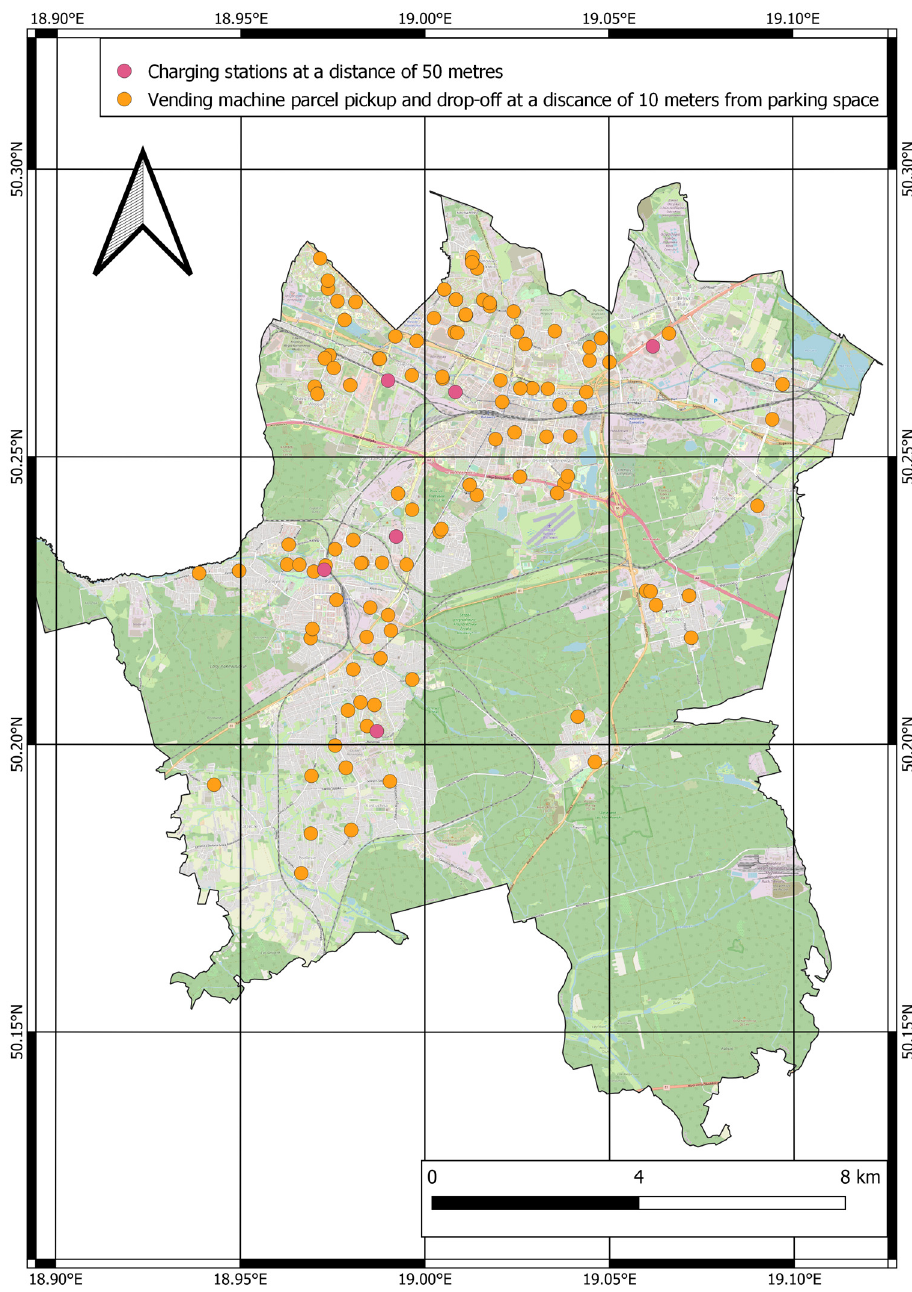
Figure 6. Locations of 115 the parcel pick-up/drop-off machines meeting the condition of a specific distance from a parking space and the 6 public stations meeting the condition of the distance to a parcel machine.